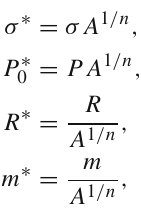
) curves 0 at the 0